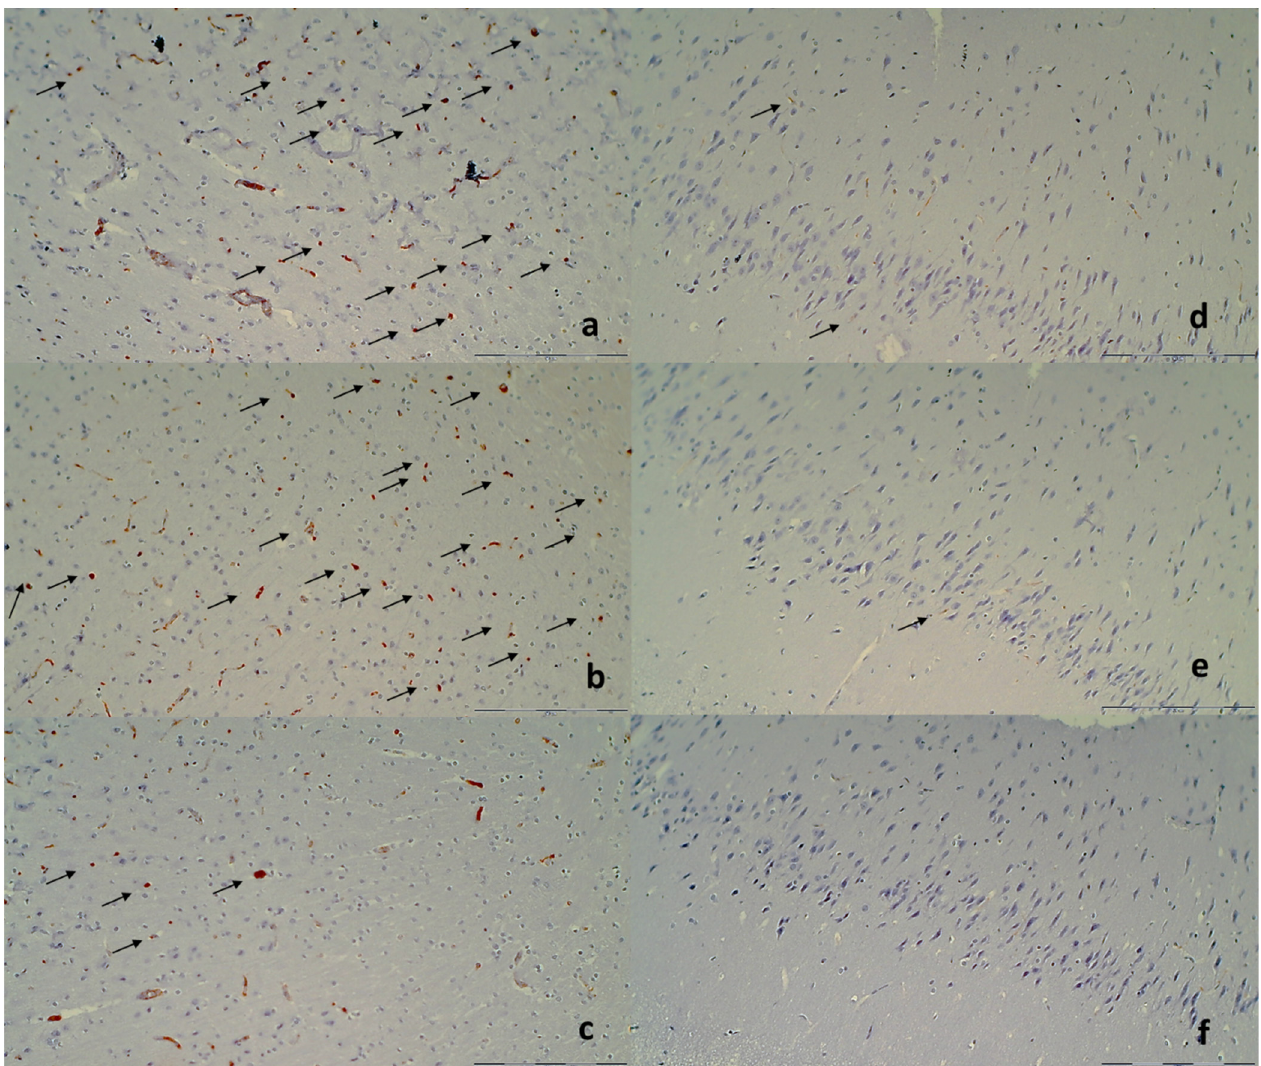
Figure 14. Immunohistochemical staining of microglial cells ( a , b ) CD68 KP1, ( c , d ) CD68 (PG-M1), ( e , f ) CD163 (marked with arrows; magnification ×400). ( a ) Control group after 48 h showed increased number of CD68 KP1 positive microglia cells with an amoeboid morphology in gray matter (score 3), while ( b ) BPC 157 with less than 5 cells (score 1). ( c ) Control group after 48 h showed increased number of CD68 (PG-M1) positive M1 type microglia cells with an amoeboid morphology in gray matter (score 3), while ( d ) BPC 157 with less than 5 cells (score 1). ( e ) Control group after 48 h showed less than 5 CD163 M2 type microglia cells with an amoeboid morphology in gray matter (score 1), while ( d ) BPC 157 with no cells (score 1). Magnification ×200 (scale bar 100 µm; Olympus BX51 objective 20×; field area 1 mm2; Note: endothelial cells were immunohistochemically labeled with all three antibodies but were excluded from scoring).